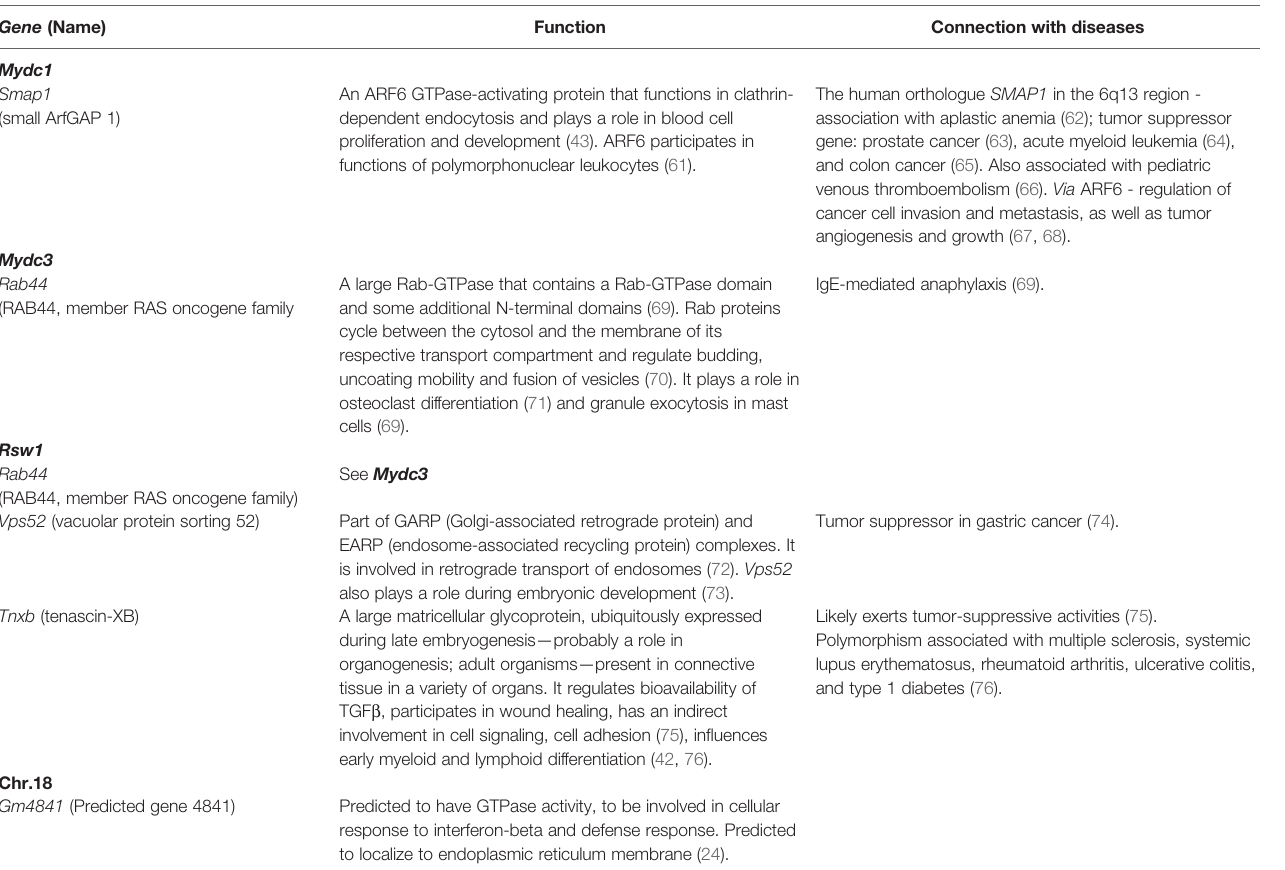
TABLE 6 | List of differentially expressed candidate genes in the strain